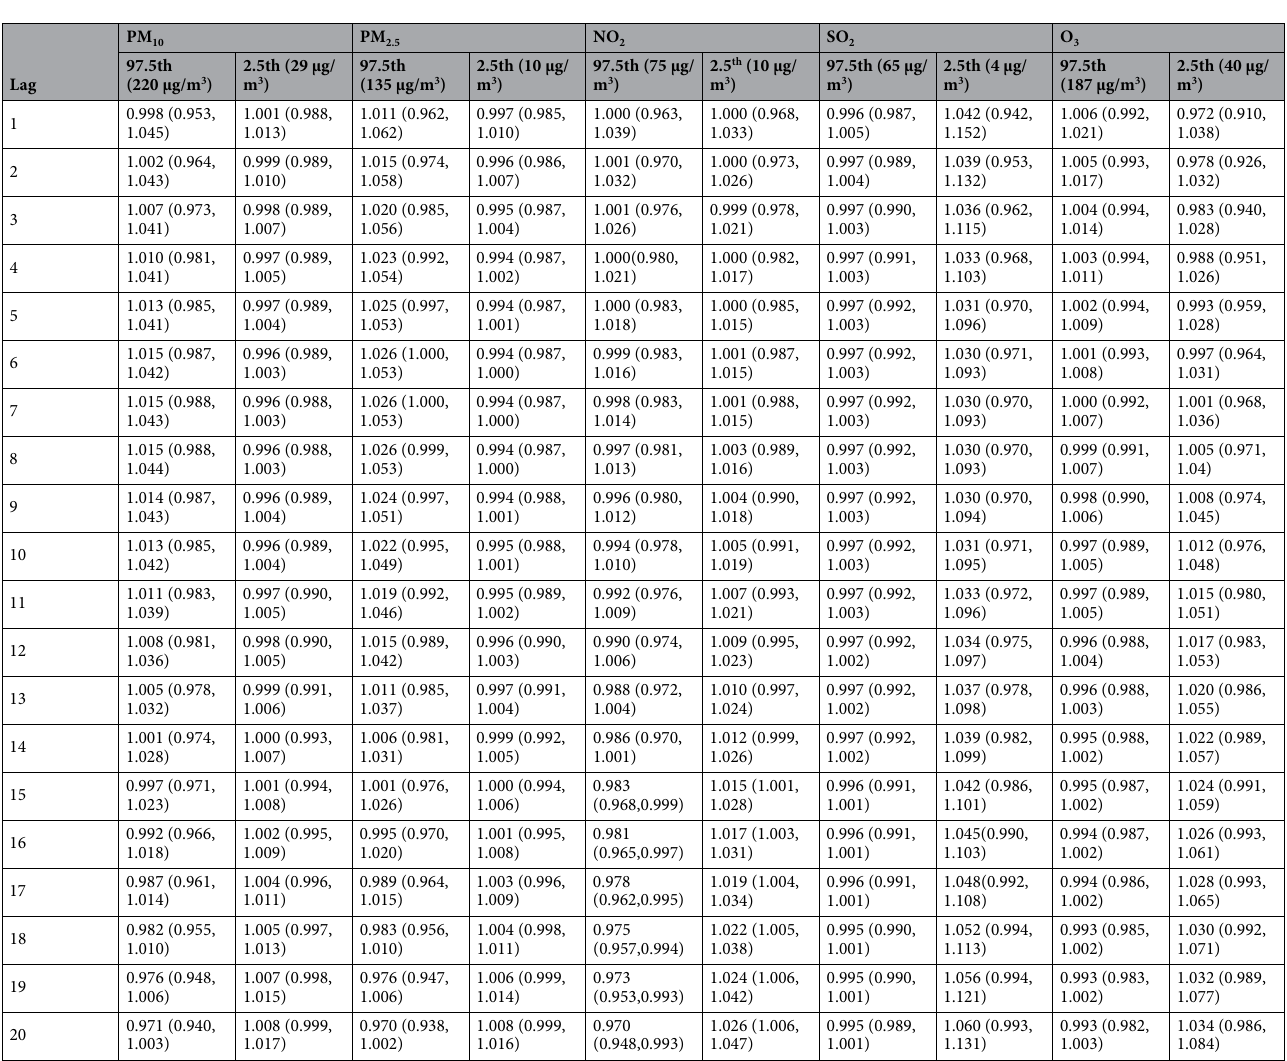
Table 2. The distributed lag effects of extreme PM 10 , PM 2.5 , NO 2 , SO 2 , O 3 concentrations on varicella at various lag days. PM 10 , particles with aerodynamic diameter less than 10 μm; PM 2.5 , particles with aerodynamic diameter less than 2.5 μm; NO 2 , nitrogen dioxide; SO 2 , sulfur dioxide; O 3 , maximum 8-h moving average ozone